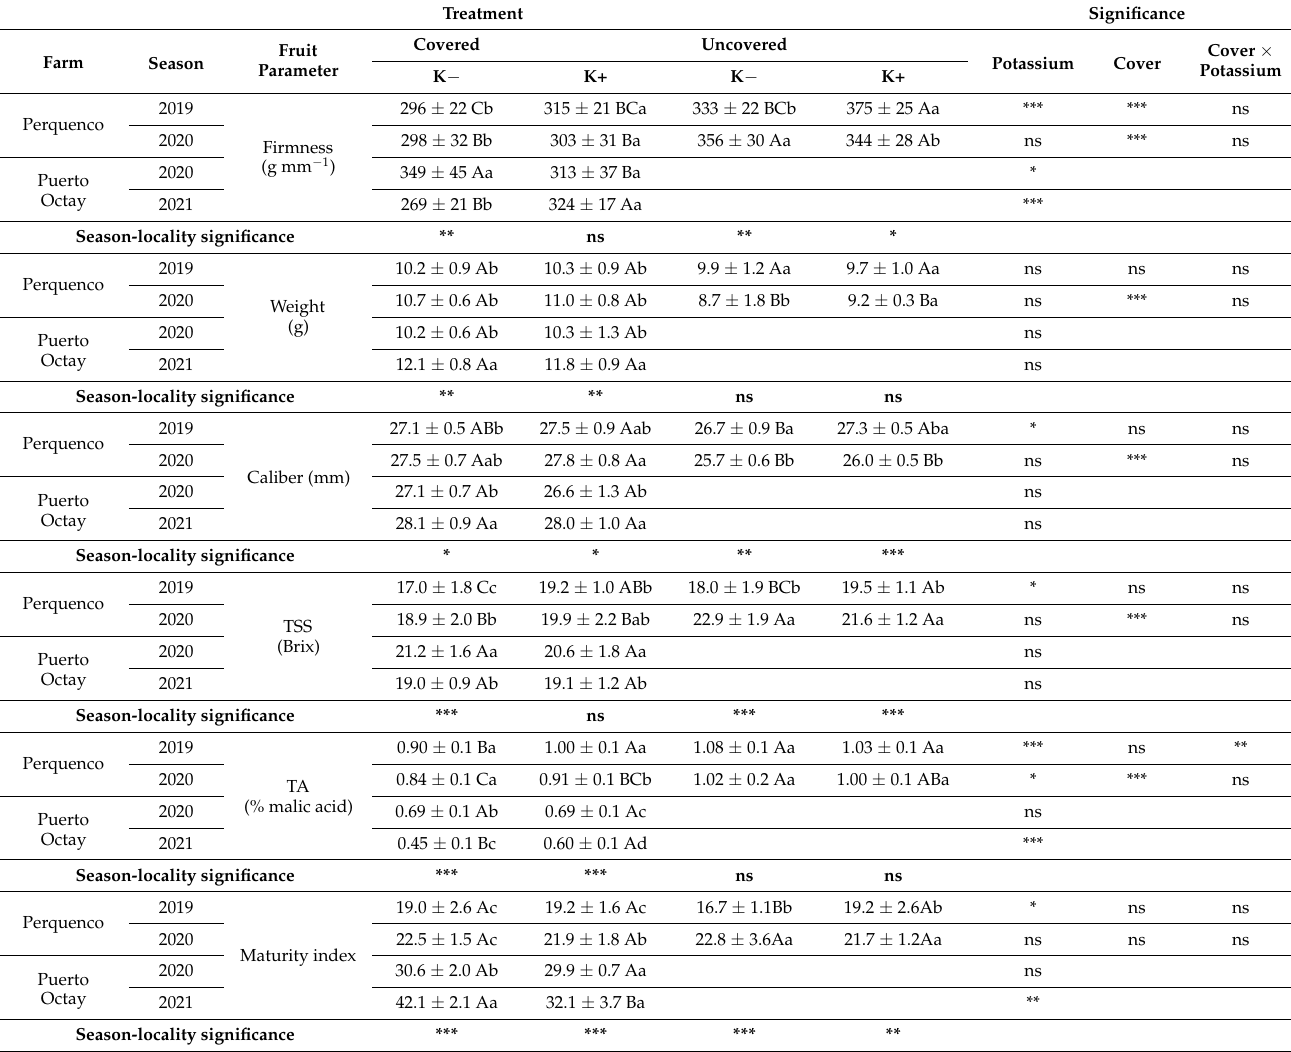
for fruit firmness were found between the cover and K fertilization treatments in the same locality (Table 1). Table 1. Fruit quality parameters at harvest in fruits of sweet cherry (cultivar Regina) cultivated in two commercial orchards located in southern Chile (Perquenco and Puerto Octay), subjected to two foliar potassium (K) treatments: conventional K regime (4 sprays during the season: K- treatment) or intensive K regime (7 sprays during the season; K+ treatment). In each location, the assays were conducted in two consecutive seasons. In the Perquenco orchard, covered and un-covered trees were compared. Abbreviations: TSS (total soluble solids), TA (titratable acidity).